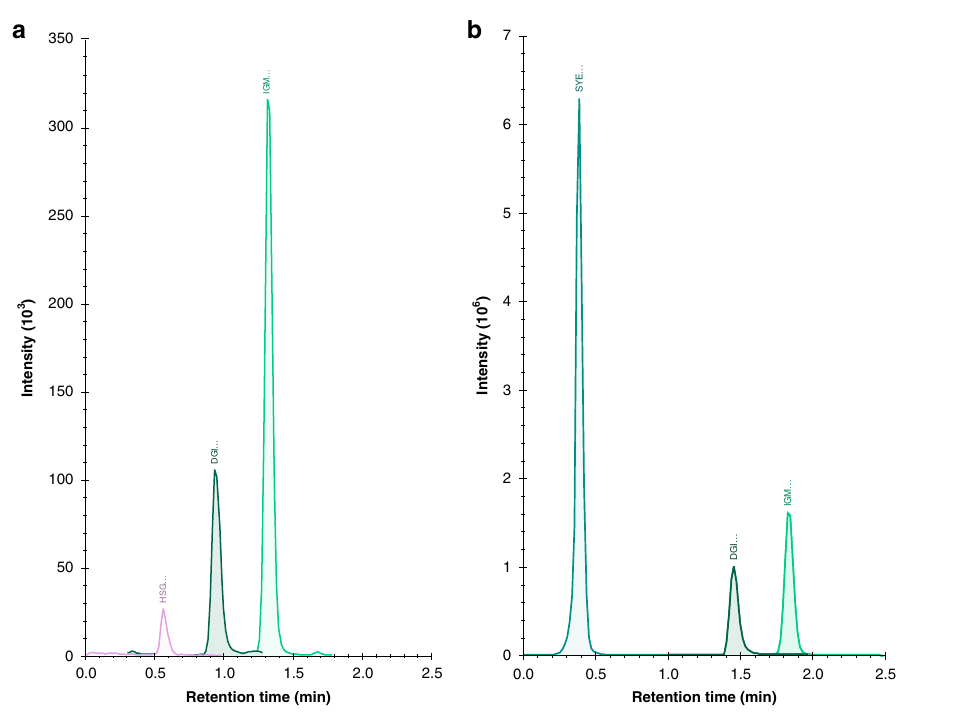
Fig. 3 Selected reaction monitoring chromatograms of SARS-CoV-2-positive clinical respiratory tract specimen showing targeted peptides. a Qualitative (Tier 3) assay; b Quantitative (Tier 1) assay. The fi rst three residues of each peptide are used to label peptide peaks: DGI (DGIIWVATEGALNTPK) and IGM (IGMEVTPSGTWLTYTGAIK) from nucleoprotein; HSG (HSGFEDELSEVLENQSSQAELK) from 15 N-labeled surrogate standard chromogranin A (in Tier 3) and SYE (SYELPDGQVITIGNER) from human beta actin (in Tier